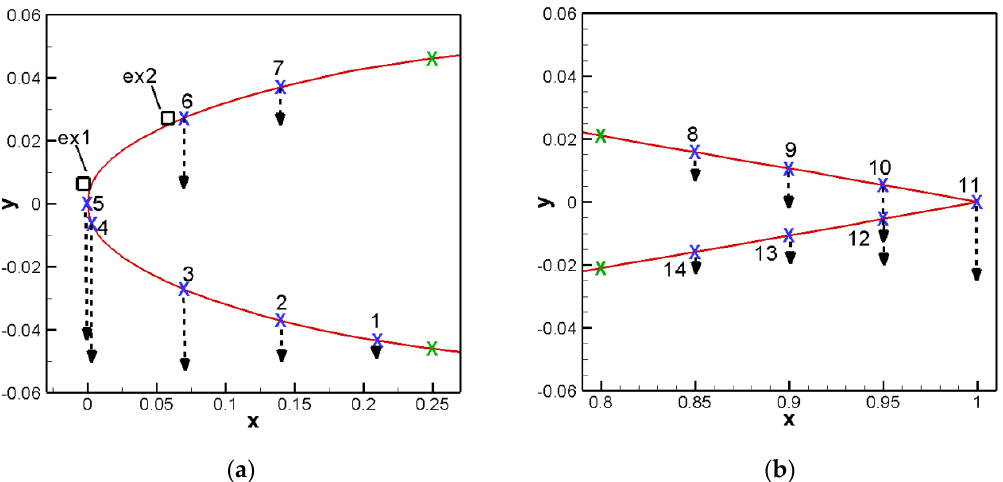
Figure 2. Definition of the x-coordinates of the control points in ( a ) the leading edge (LE)region and ( b ) the trailing edge (TE) region. The black dashed arrows indicate that control points are expected to be shifted downwards with respect to the original geometry. Fixed control points are shown with green color. The additional control points ex1 and ex2, on the upper side of the LE, are depicted with squares.